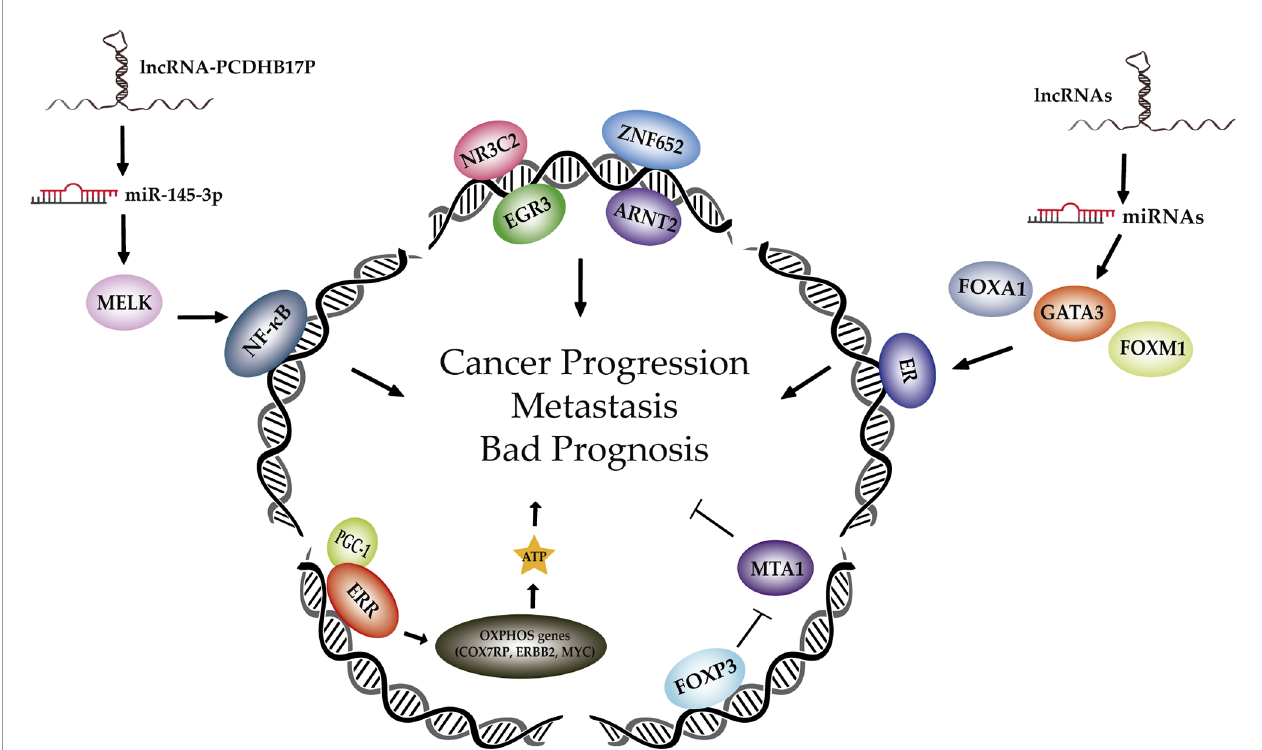
FIGURE 1 | Different transcription factors and associated regulatory members involved in breast cancer progression and metastasis. Schematic representation on recent advances in the discovery of new TF, miRNAs and lncRNAs implicated in BC tumorigenesis. Known TFs involved in BC tumorigenesis are in grey while the emerging ones explained in this topic appear in colour. Abbreviations: ribonucleic acid (RNA), microRNA (miRNA), long non-coding RNA (lncRNA), maternal embryonic leucine zipper kinase (MELK), nuclear factor kappa B (NF- k B), nuclear receptor subfamily 3 group C member 2 (NR3C2), zinc fi nger protein 652 (ZNF652), early growth response 3 (EGR3), aryl hydrocarbon receptor nuclear translocator 2 (ARNT2), estrogen receptor (ESR), forkhead box A1 (FOXA1), GATA binding protein 3 (GATA3), forkhead box M1 (FOXM1), forkhead box P3 (FOXP3), metastasis-associated 1 (MTA1), estrogen related receptor (ERR), peroxisome proliferator-activated receptor- g coactivator-1 (PGC-1), oxidative phosphorylation (OXPHOS), cytochrome c oxidase subunit 7a related polypeptide (COX7RP), receptor tyrosine kinaseerbB 2